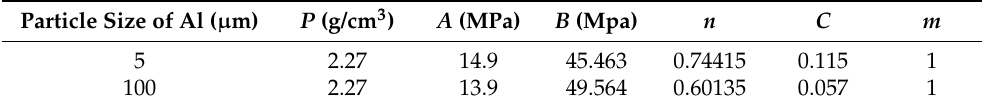
Table 1. The parameters of the Johnson–Cook constitutive model.